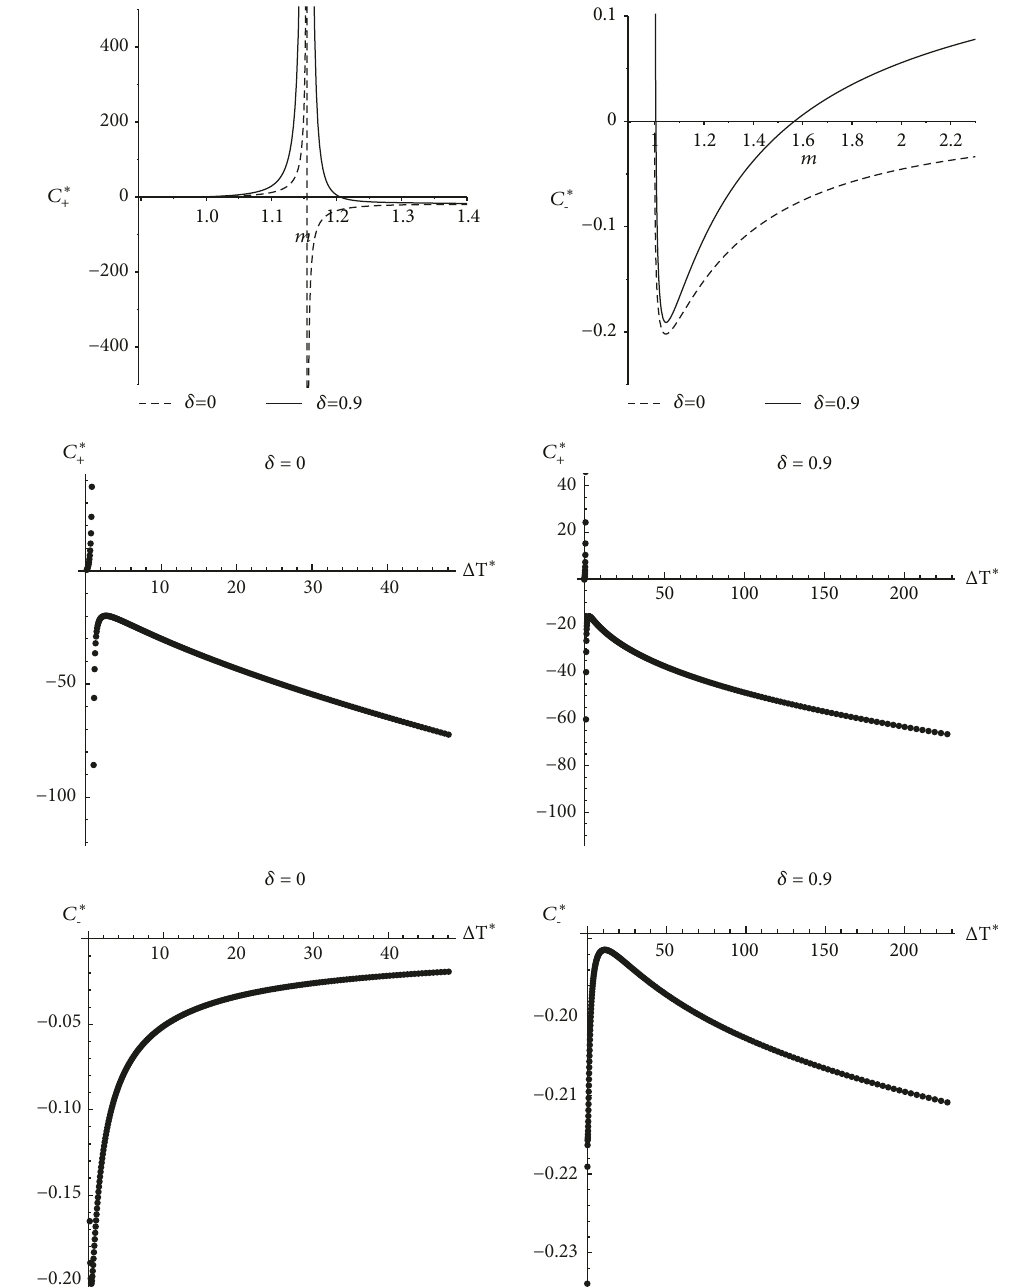
Figure 5: Diagram of interior and exterior horizons heat capacities 𝐶 ∗ ± is plotted against 𝑚 and Δ𝑇 ∗ for 𝛿 = 0 and 𝛿 = 0.9